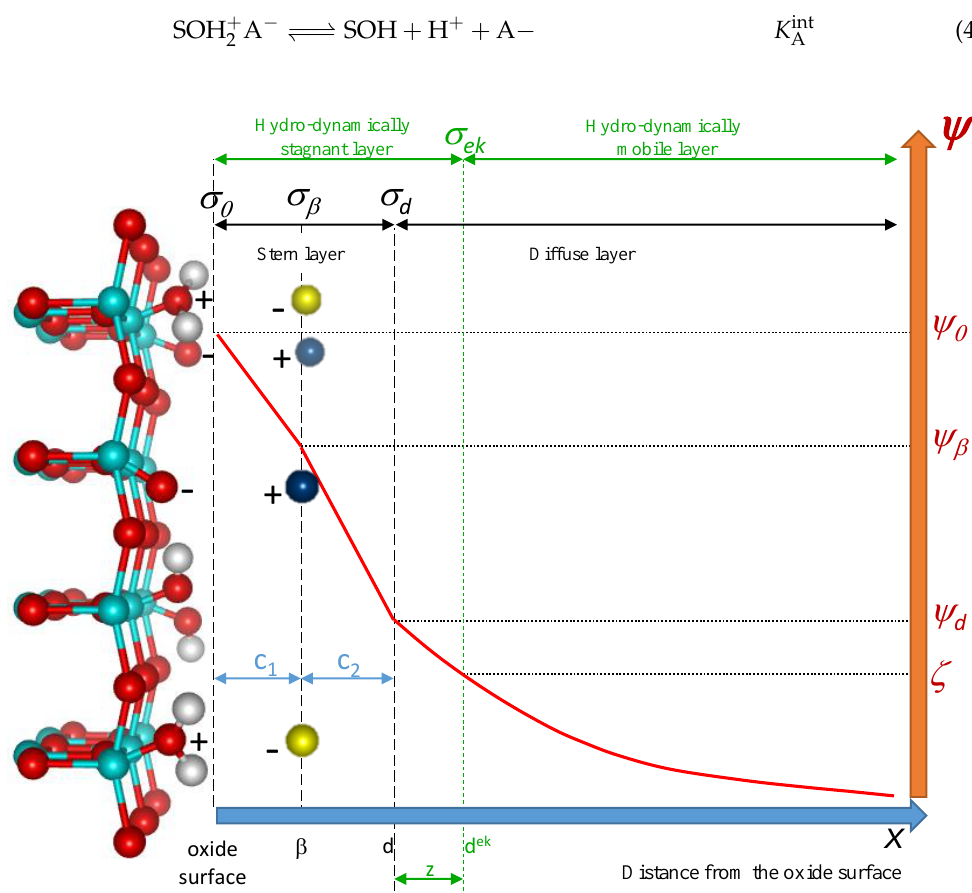
Figure 1. Schematic representation of the charge densities and potentials in a triple-layer model (TLM) configuration with three charged planes: metal oxide surface; β plane, where associated counter ions are located; d plane, onset of the diffuse layer. The 2 different pKs are a consequence of the amphoteric character of the surface hydroxyl groups. In the figure, the hydro-dynamically stagnant and mobile layers are also depicted in